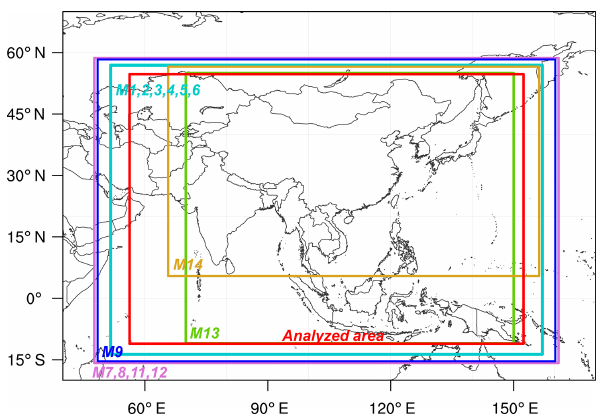
Figure 1. Simulation domain for each participant model. The final analyzed region is also